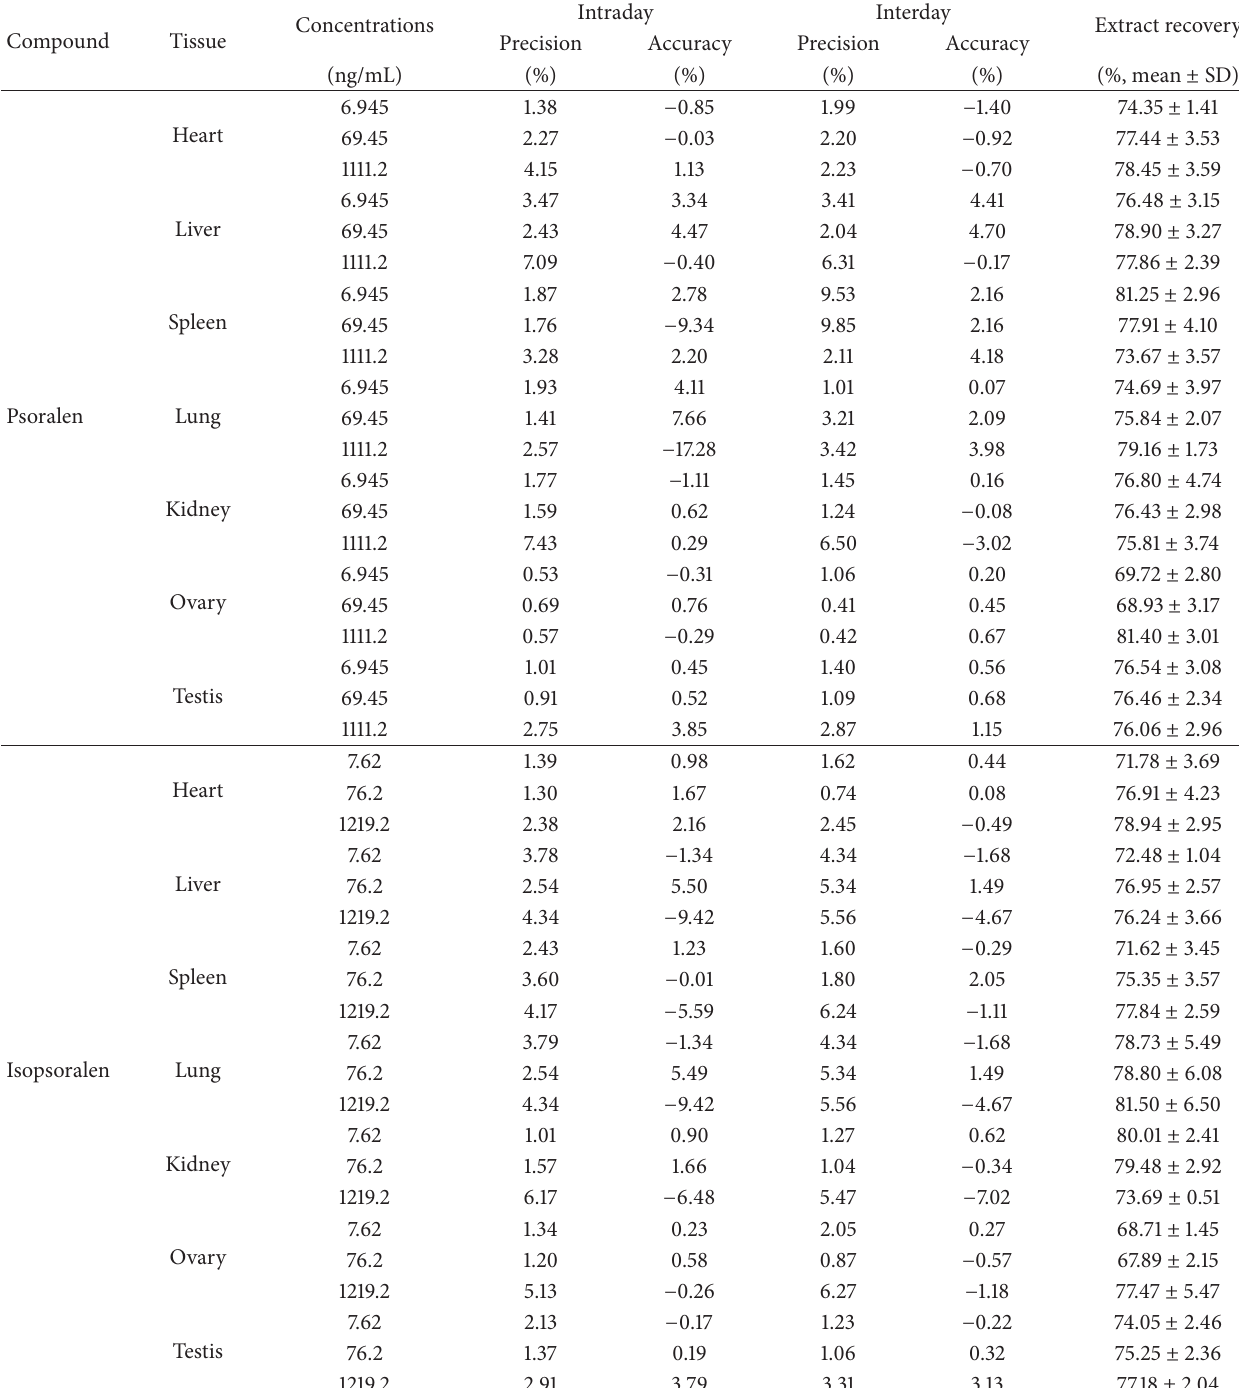
Table 2: Intra-assay and interassay precision, accuracy, and extract recovery of psoralen and isopsoralen in rat tissues ( 𝑛 = 3 for sexual organs; 𝑛 = 6 for other